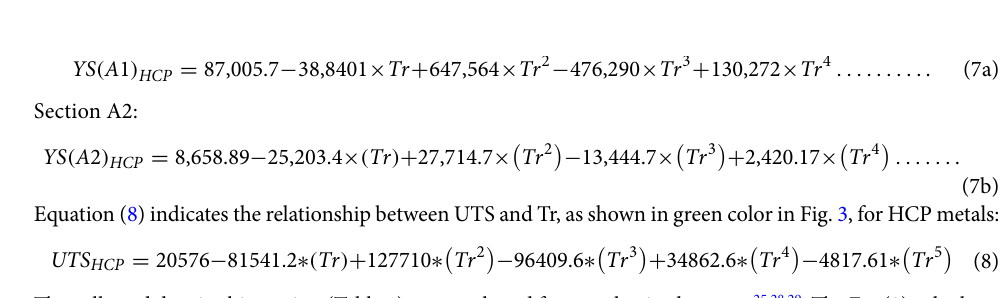
The collected data in this section (Table 1) were gathered from authorized sources 25,28,29 . The Eq. (9) calculates the convergence (Conv1) between the values of the standard YS coming from tensile tests, according to ASTM (YS ASTM ), and the YS values calculated from the proposed method (YS cal ) in this study (Eqs. 3, 5, 7).